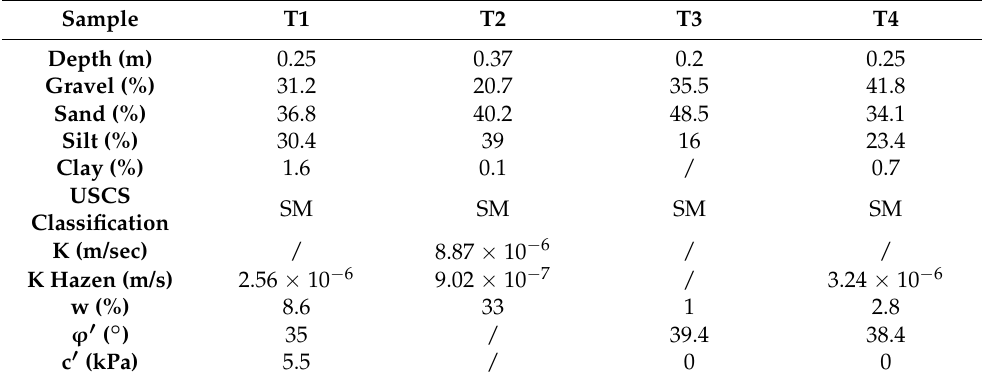
Figure 6. Mohr–Coulomb failure envelope for samples T1, T3 and T4. Table 2. Summary of the geotechnical parameters of the four samples collected from the Theilly land- slide. K = permeability constant load test; w = water content; ϕ (cid:48) = friction angle; and c (cid:48) =